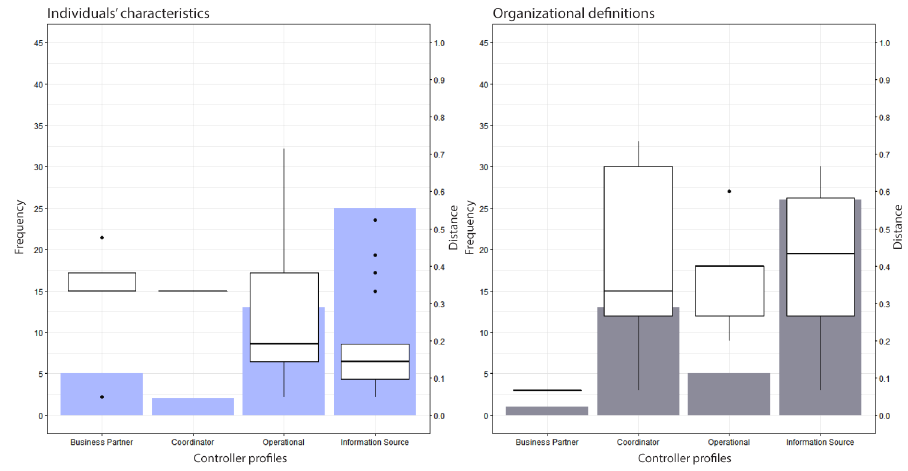
Figure 6. Frequency and dispersion of the distance between the first and second most dominant profiles for